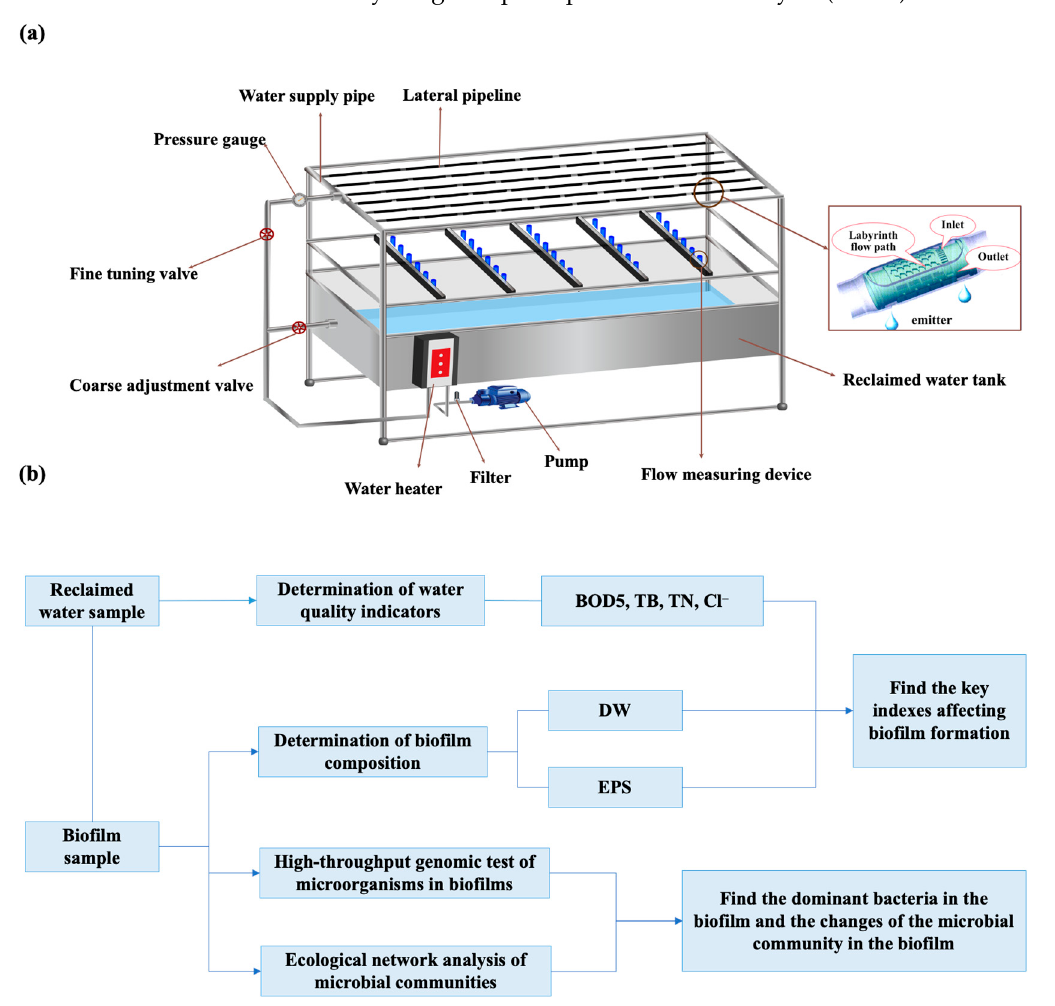
Figure 1. System setup in this work. ( a ) Layout of the agricultural reclaimed water distribution system for testing in this work; ( b ) A method diagram of the working principle in this work.